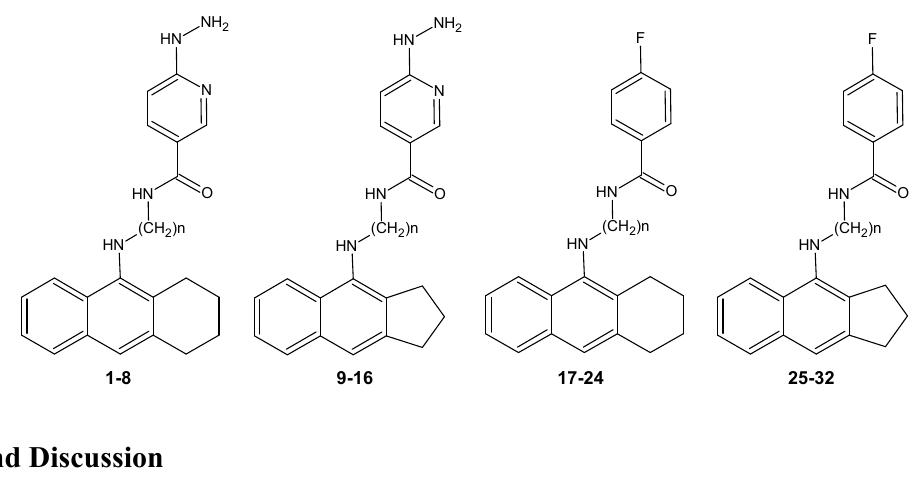
Figure 1. Analyzed compounds: tetrahydroacridine derivatives 1 – 8 and 17 – 24 ; cyclopenta[b]quinoline derivatives 9 – 16 and 25 – 32 [11–16].